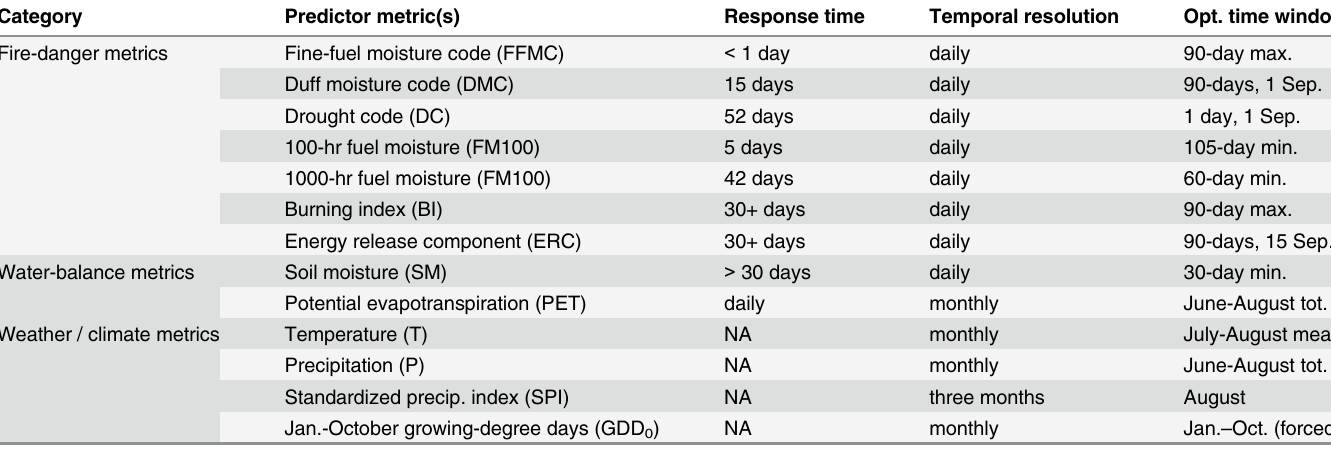
Table 1. Climate metrics used to predict the natural logarithm of annual area